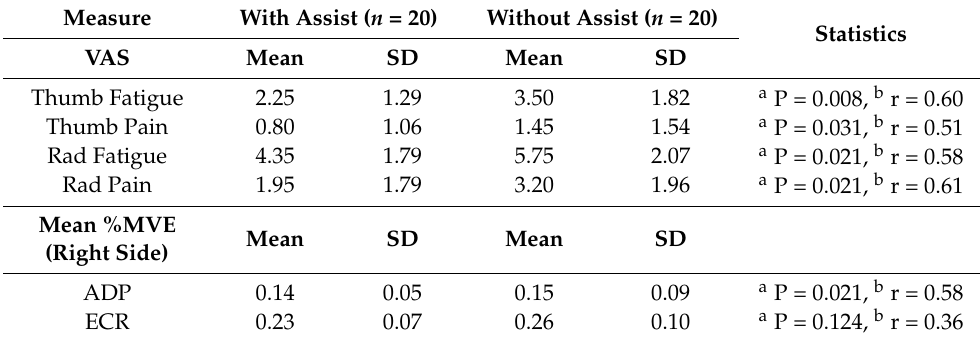
Table 2. Difference in variables due to the assistance of power-support